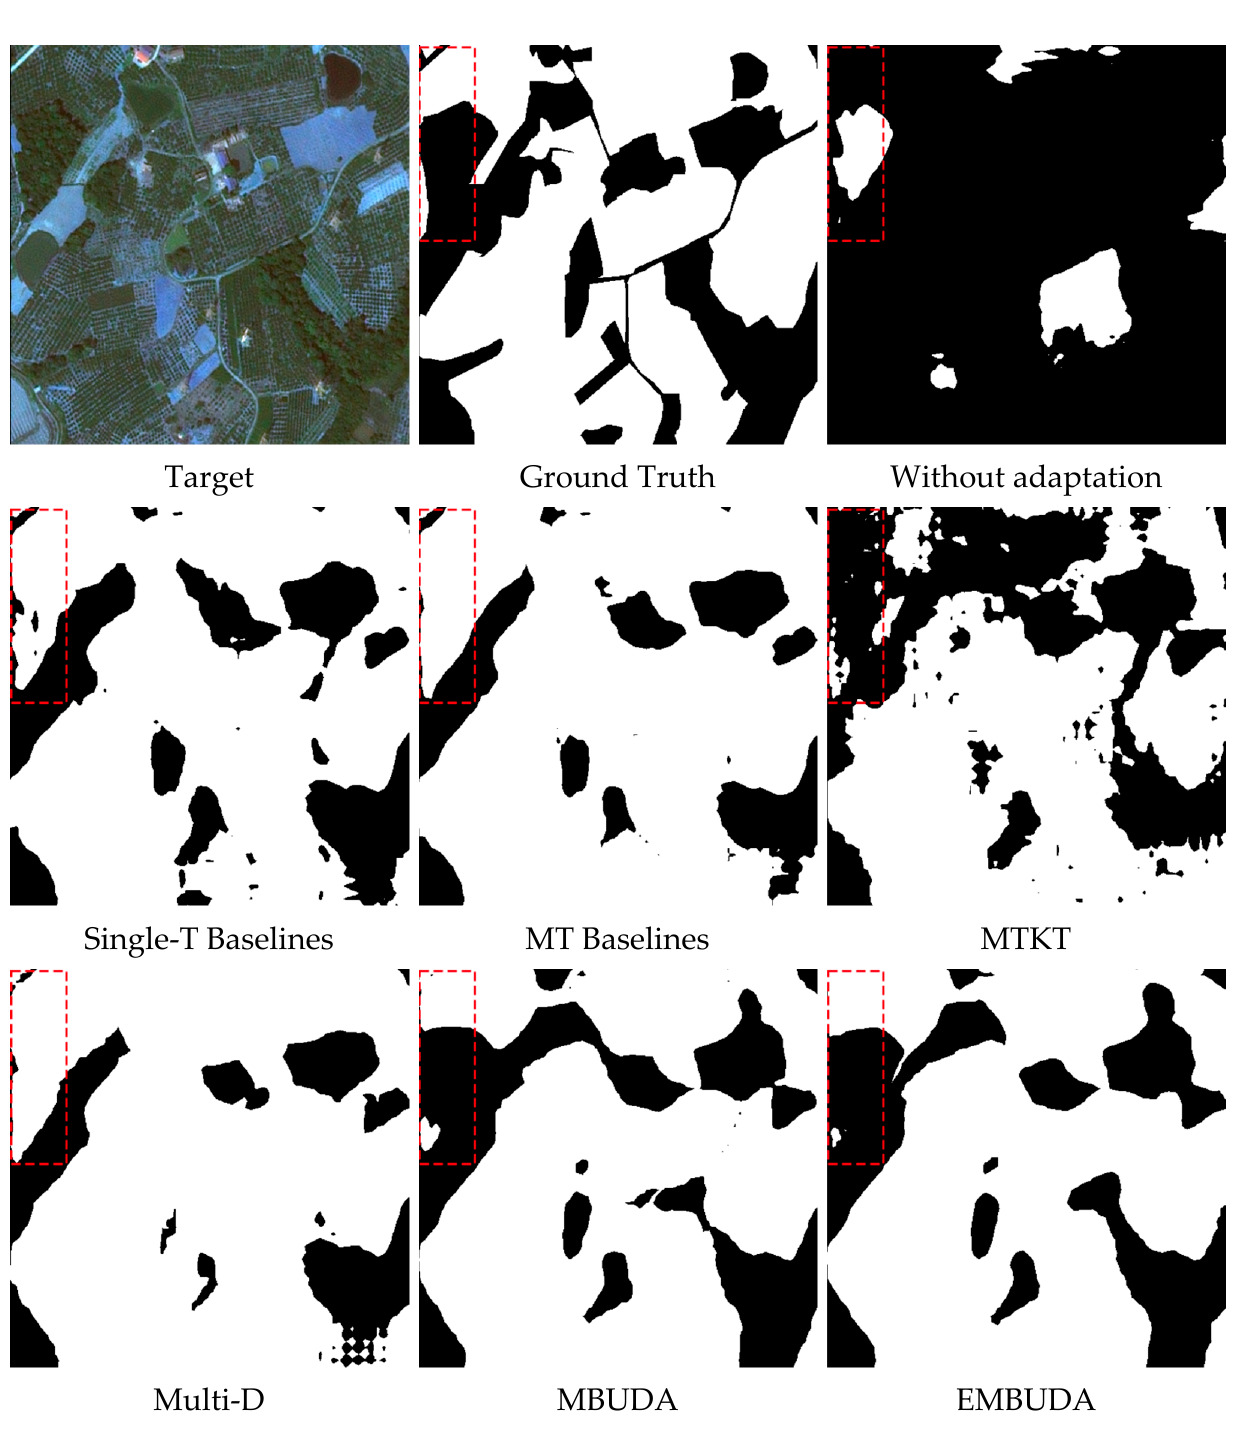
Figure 9. Outputs of orchard area segmentation in Dataset XT2 when adapting from Dataset ZG to Dataset CY, Dataset XT1, and Dataset XT2.